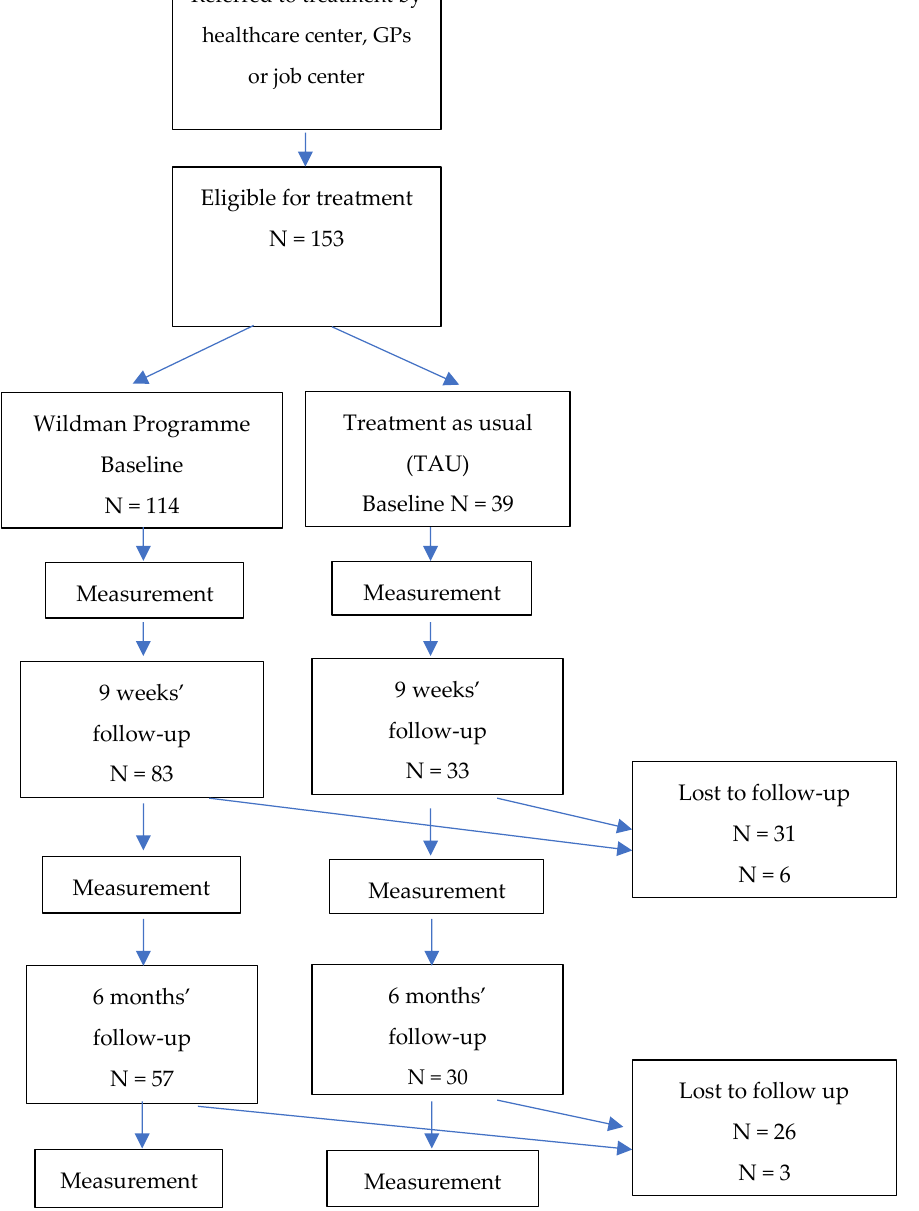
Figure 2. Flowchart for the study of the ‘Wildman Programme’.